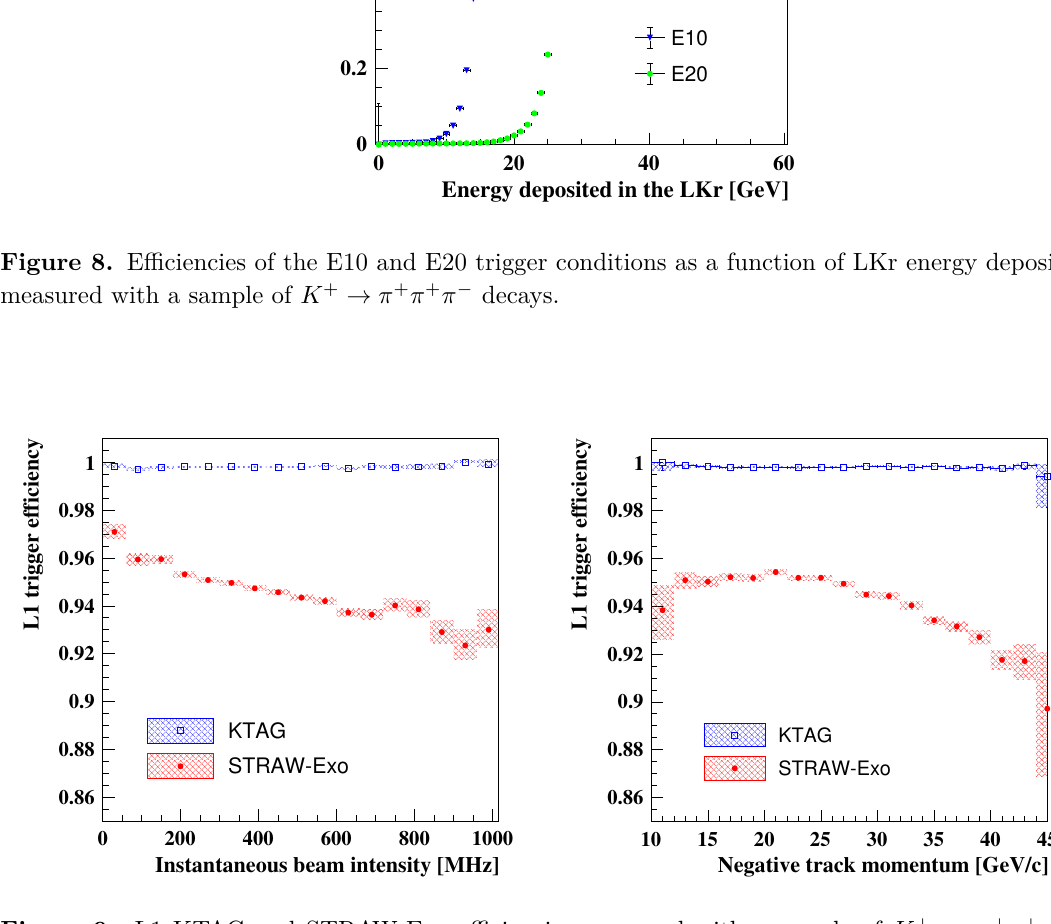
Figure 9. L1 KTAG and STRAW-Exo efficiencies measured with a sample of K + → π + π + π − decays as functions of instantaneous beam intensity (left) and π − momentum (right). The hatched areas indicate the statistical uncertainties of the